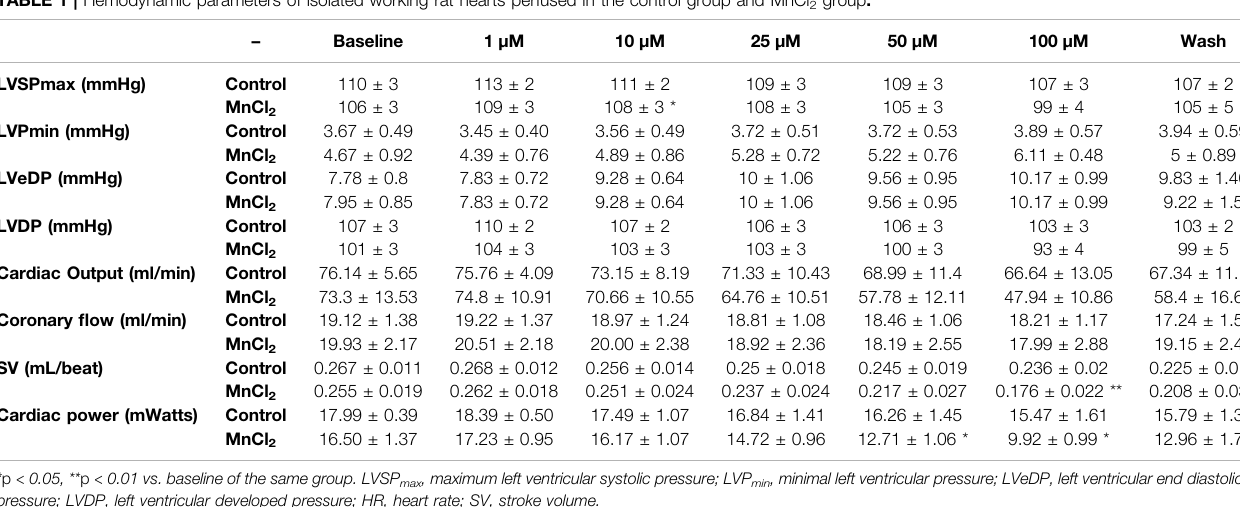
Frontiers in Physiology |